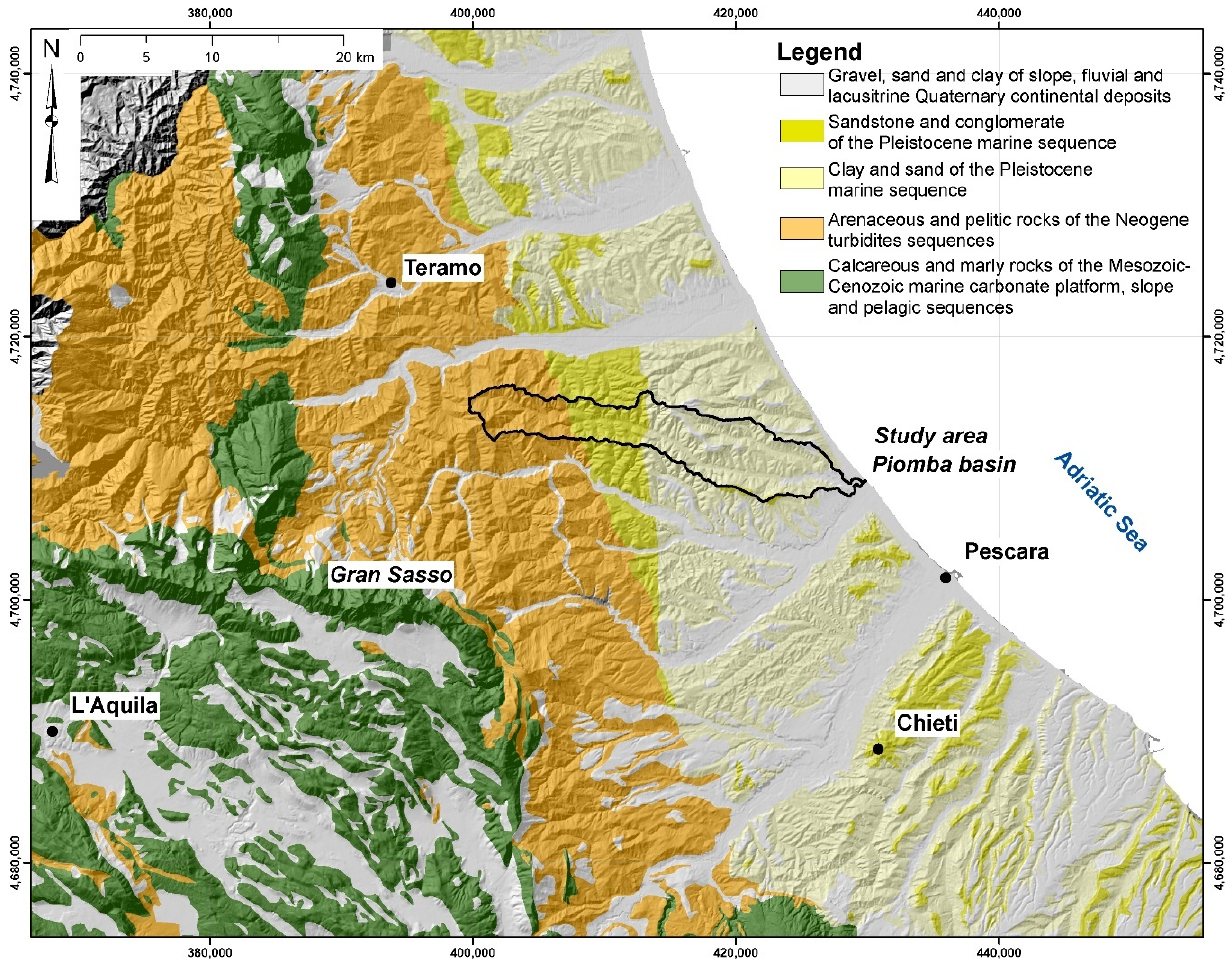
Figure 2. Geologic scheme of the Abruzzo region. The black line indicates the watershed boundary of the study basin (grid in UTM WGS84 coordinates, UTM zone 33 N).